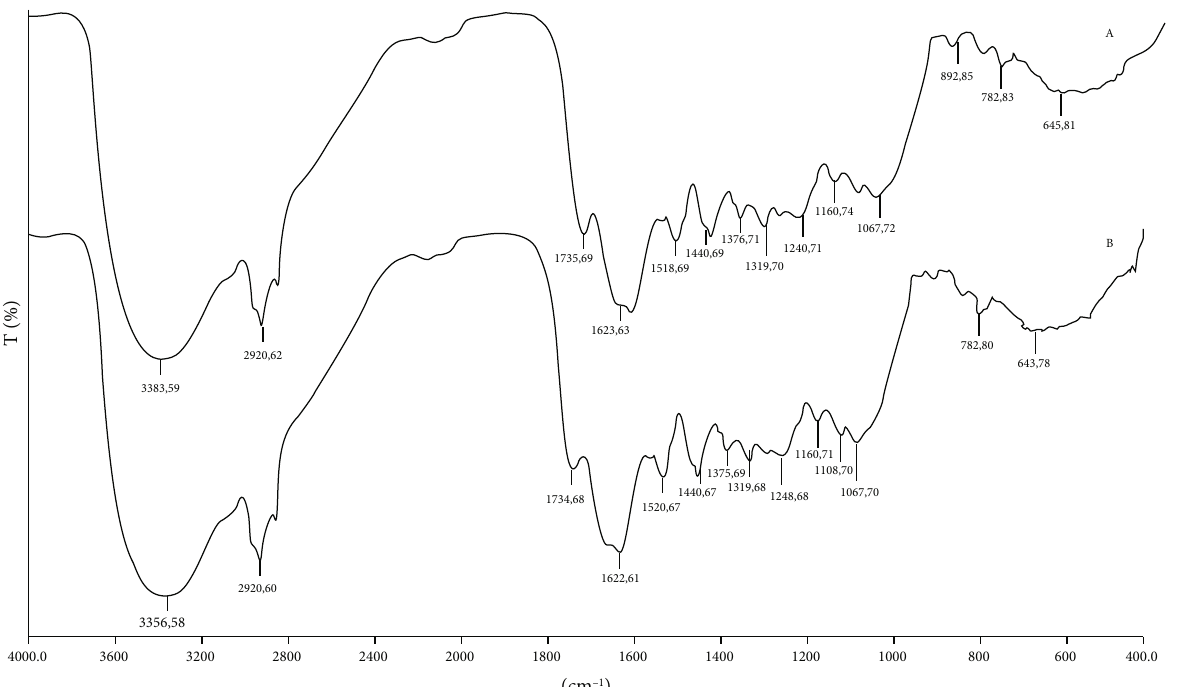
Figure 3: FTIR spectra of (a) unloaded Neolamarckia cadamba ; (b) loaded with methylene blue of Neolamarckia cadamba leaves.